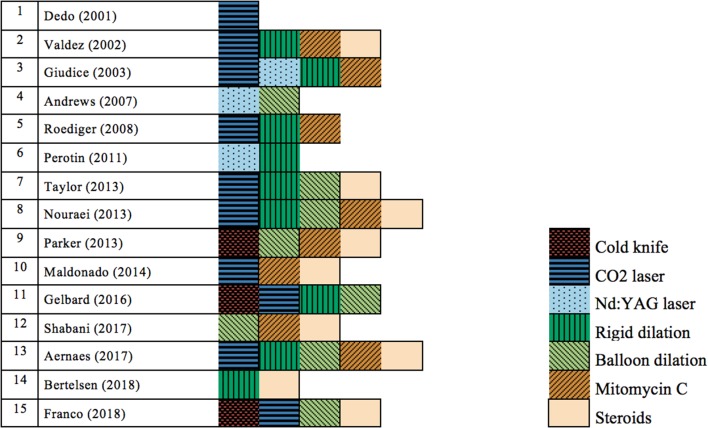
Distribution of the used techniques for treatment of patients with idiopathic subglottic stenosis in the different selected trials, coded by color. CO2 laser, carbon dioxide laser; Nd:YAG laser, neodymium-doped yttrium aluminum garnet laser.